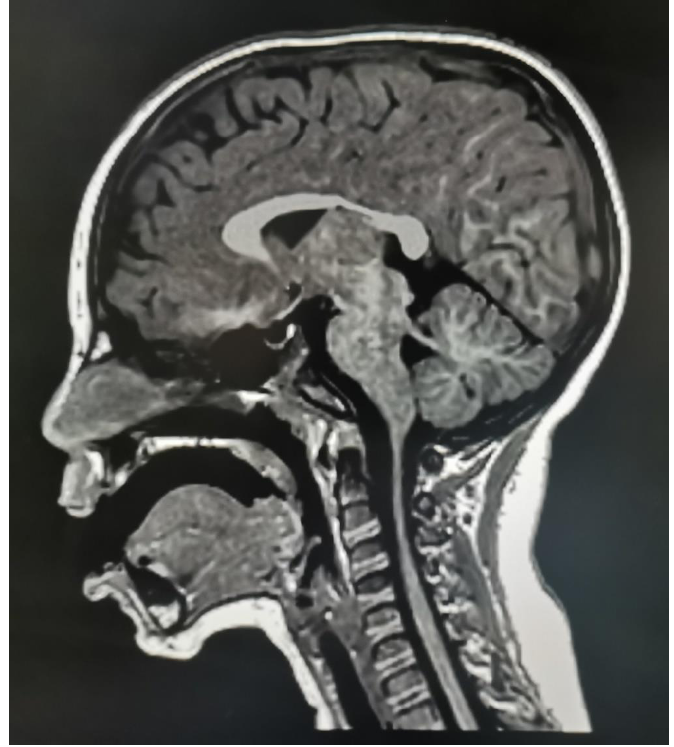
Figure 1. Cerebral magnetic resonance imaging (MRI) scan showing posterior hypoplasia of corpus callosum.